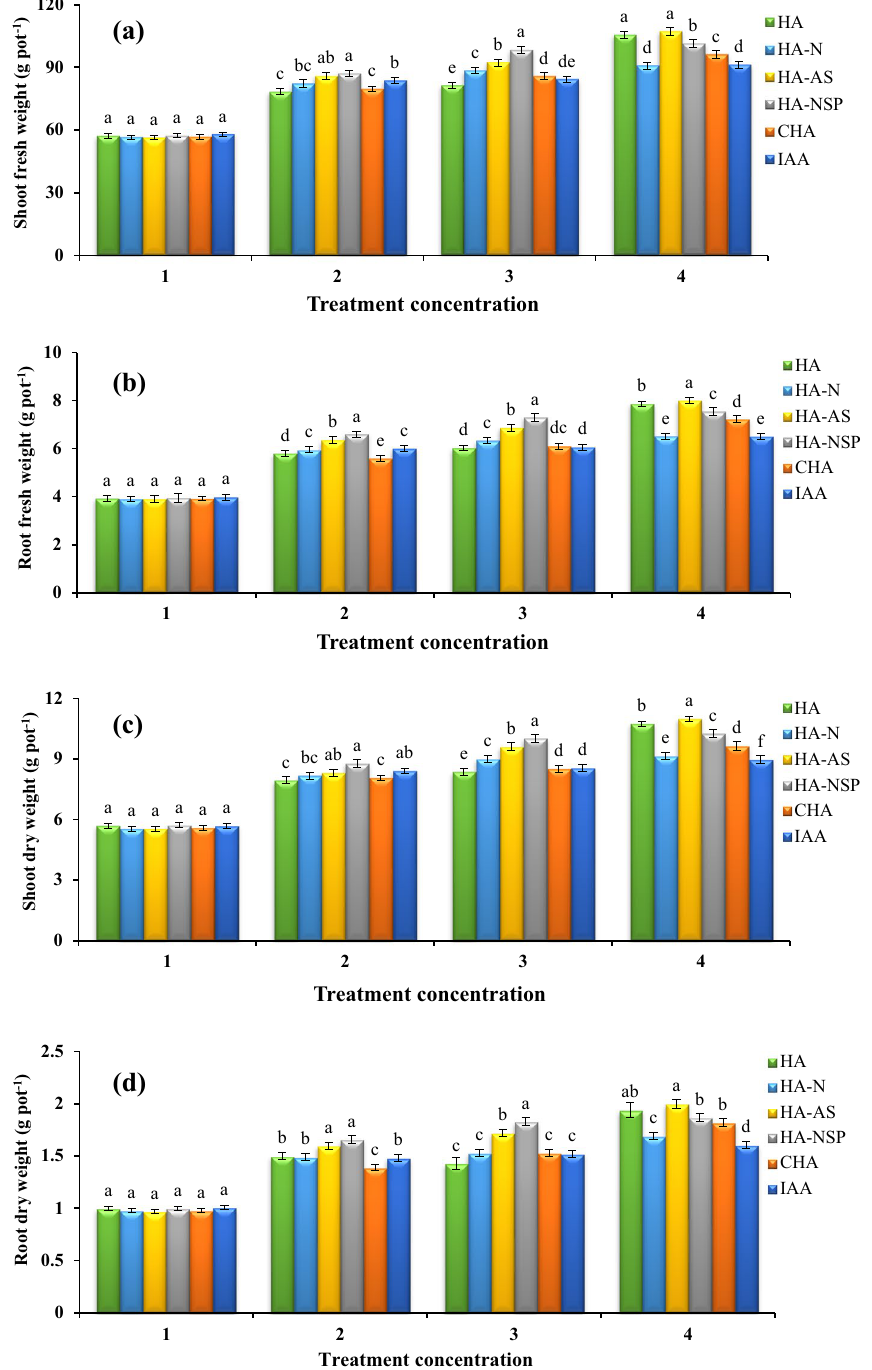
Figure 3. Comparison of average foliar application of experimental treatments on shoot fresh weight ( a ), root fresh weight ( b ), shoot dry weight ( c ) and root dry weight ( d ) at treatment concentrations (levels 1, 2, 3 and 4 for HA, HA-N, HA-AS, HA-NSP and CHA treatments of 0, 200, 400 and 600 mg L −1 and 0, 10 –6 , 10 –5 and 10 –4 molar IAA). Different letters in each figure show significant difference at p ≤ 0.05 by Duncan multiple range test. HA, HA extracted from vermicompost without enrichment; HA-N, HA extracted from vermicompost enriched with 1% nitrogen; HA-NSP, HA extracted from vermicompost enriched with 1% nitrogen, 1% sulfur, and 1% phosphorus; HA-AS, HA extracted from vermicompost enriched with Azotobacter chroococcum (21Az) + Pseudomonas fluorescens (Ps 59); CHA, Commercial humic acid; IAA, Indole-3-acetic acid